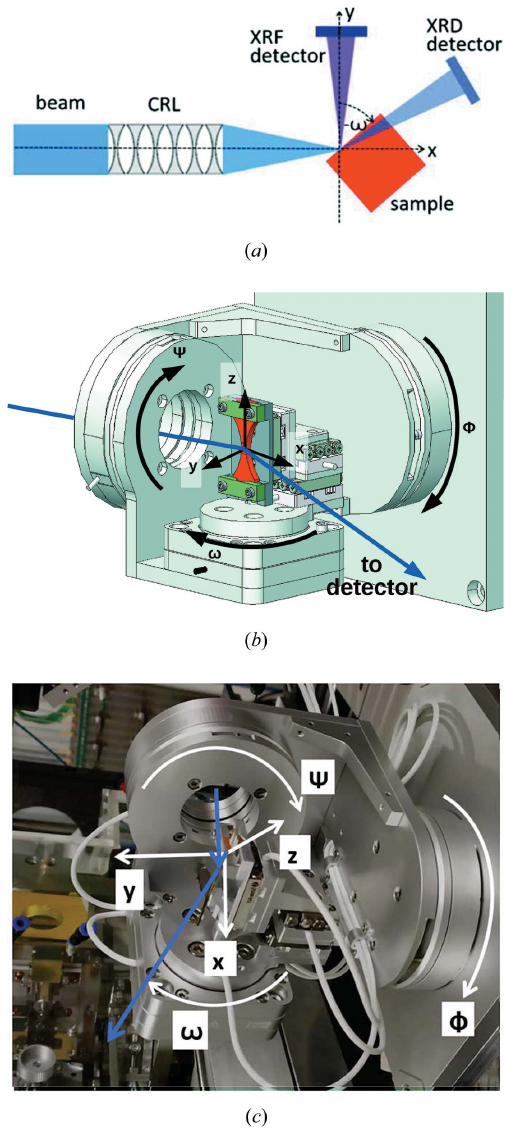
Figure 1 ( a ) The setup geometry (top view). ( b ) A technical drawing of the goniometer. The positioners are stacked from outer to inner in the order (cid:2) , (cid:3) , ! , y , x and z . ( c ) A photograph of the